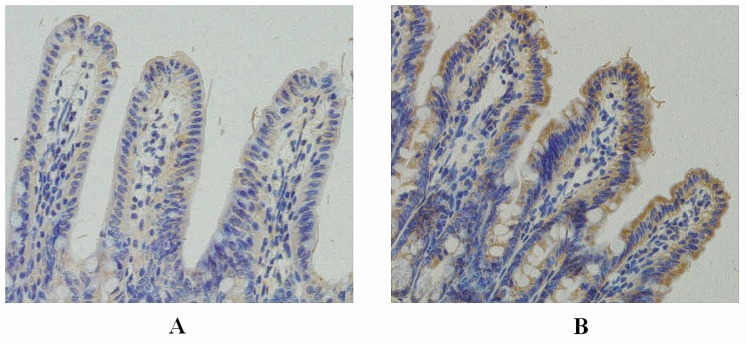
Expression of TLR4 in the terminal ileum (×200; immunohistochemistry).A: Immunohistochemistry revealed faint positive staining for TLR4 in the ileal epithelium of the SH group; B: In the OJ group, strong positive staining of TLR4 was visualized in the membrane and cytoplasm of ileum epithelial cells on the 7th day after operation.